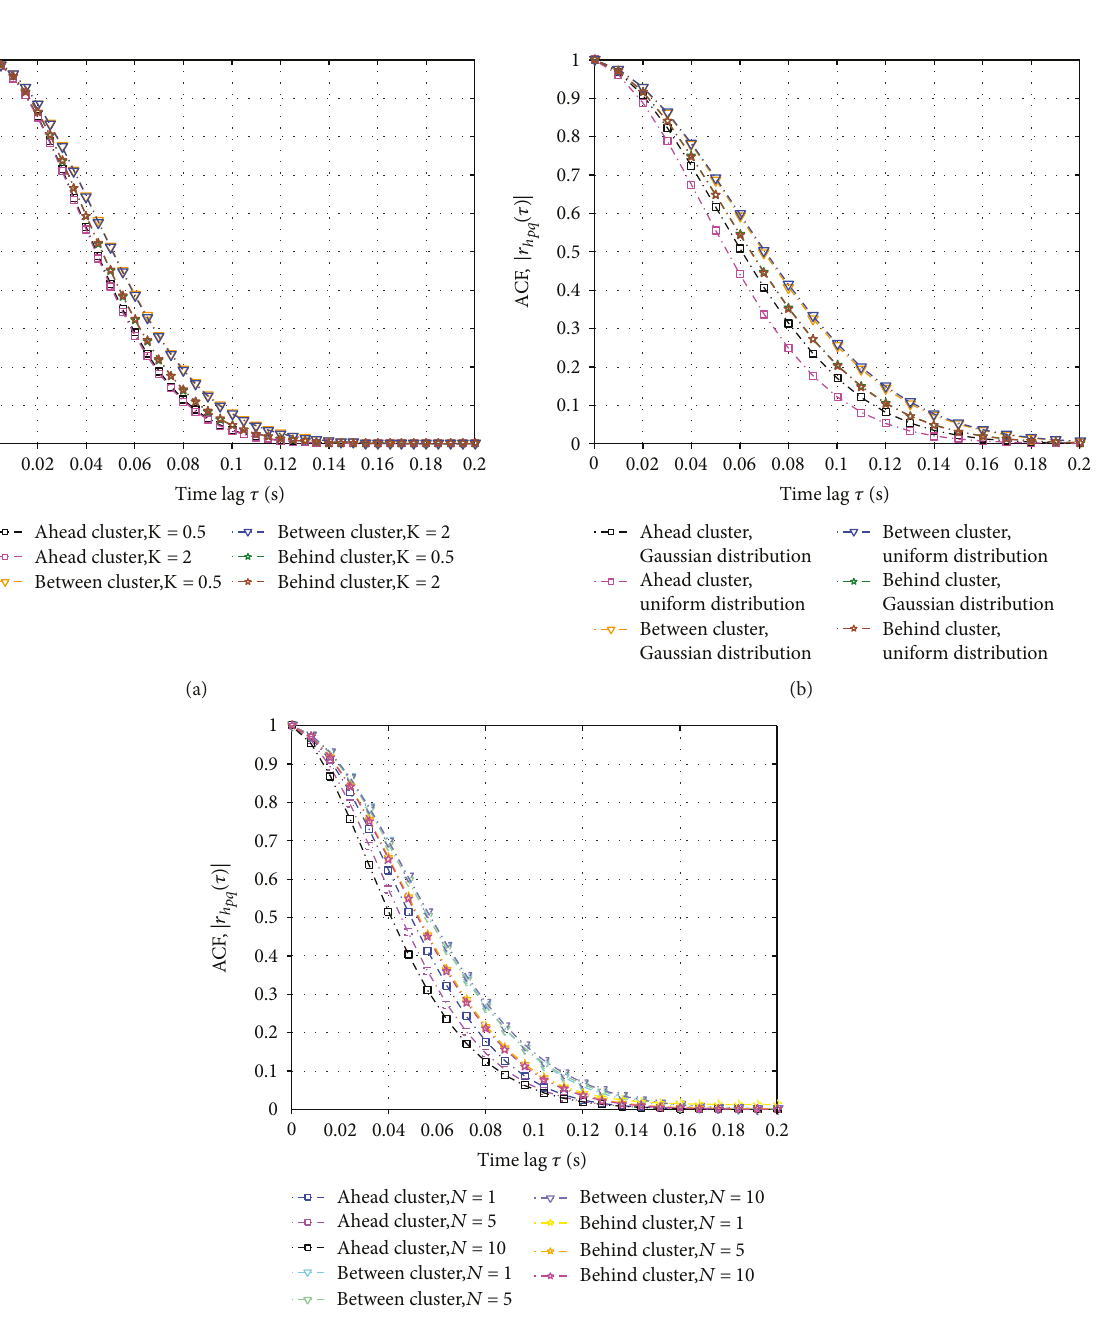
τ of the reference model under (a) di ff erent Ricean factors K , di ff erent distributions of scatterers Figure 9: The absolute value of the ACF r h pq and di ff erent number of clusters over three